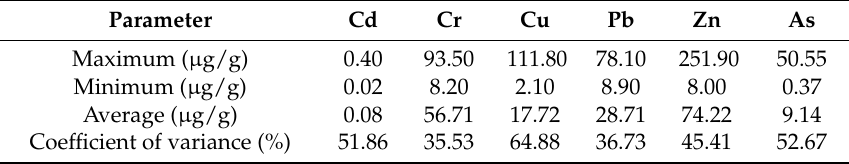
Table 4. General characteristics of the heavy metals contents in surface sediments from the study